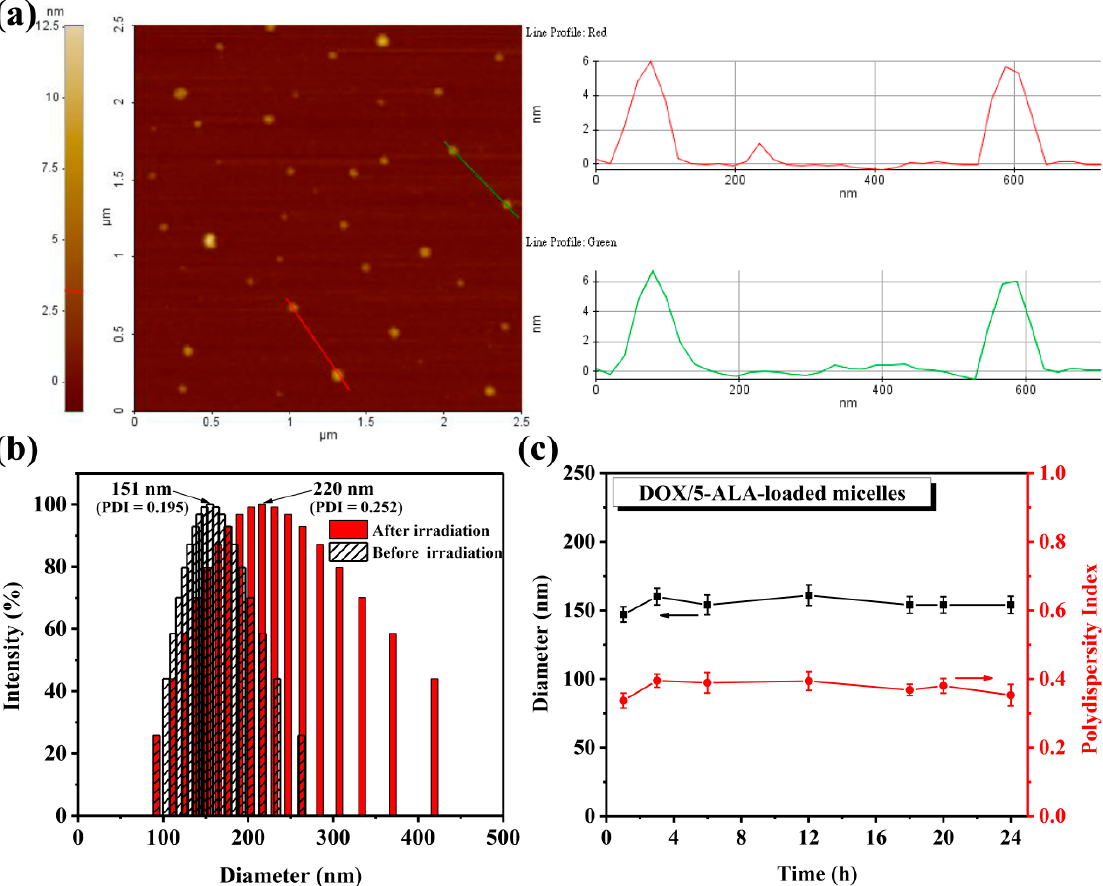
Figure 1. ( a ) Atomic force microscopy (AFM) image of DOX/5-ALA-loaded A-PPG micelles coating on silicon wafer. Cross-section analysis presenting the height distribution along the red and green lines. ( b ) dynamic laser scattering (DLS) analysis of the size distribution of micelles before and after laser irradiation. ( c ) Kinetic stability of DOX/5-ALA-loaded A-PPG micelles in PBS containing 10% fetal bovine serum (FBS) over time at pH 7.4.